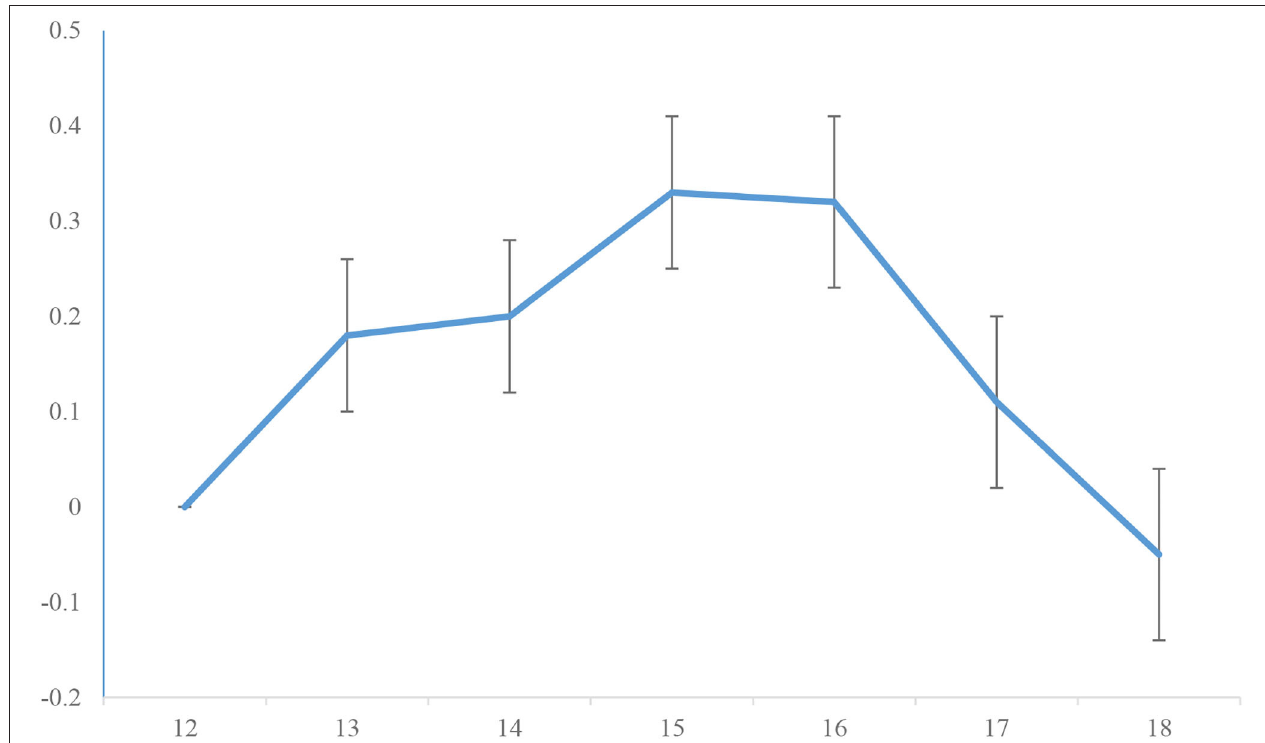
FIGURE 1 | Plot of latent means of identity diffusion for age groups 12 through